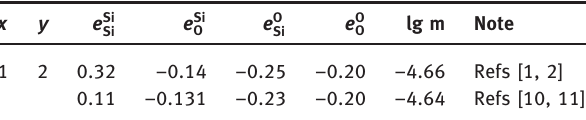
Table 1: Data on calculation of silicon deoxidation equilibrium curve at 1,873 K.